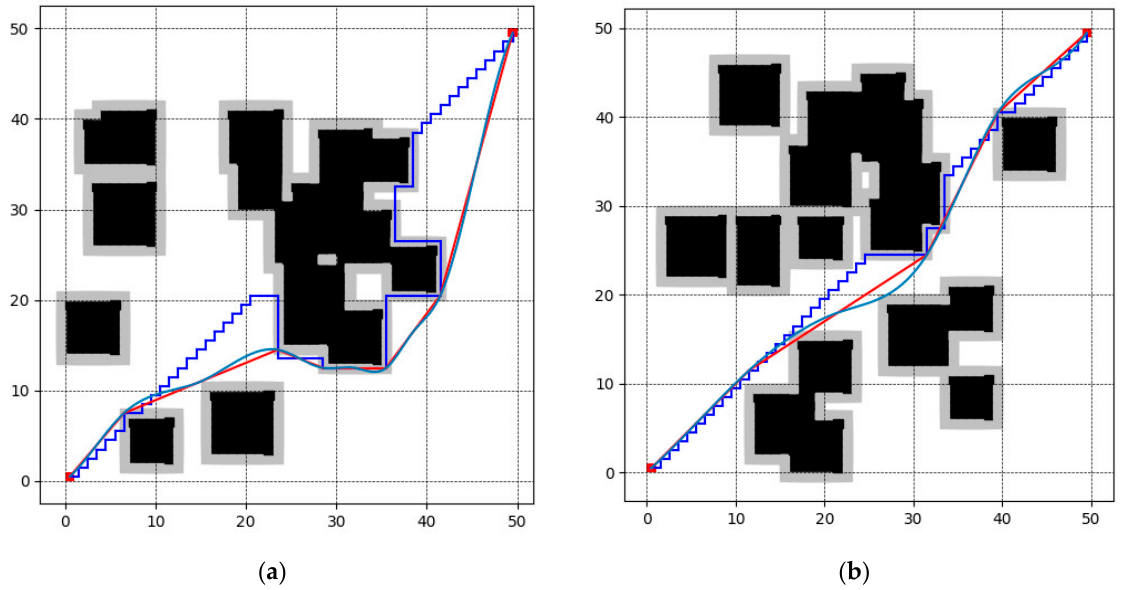
Figure 23. Mobile robot path using traditional A* algorithm (blue lines), our improved A* algorithm without smooth cost (red lines), and our improved A* algorithm with all cost functions (green lines): ( a ) Scenario 6 with random obstacles and ( b ) Scenario 7 with more complex obstacles.